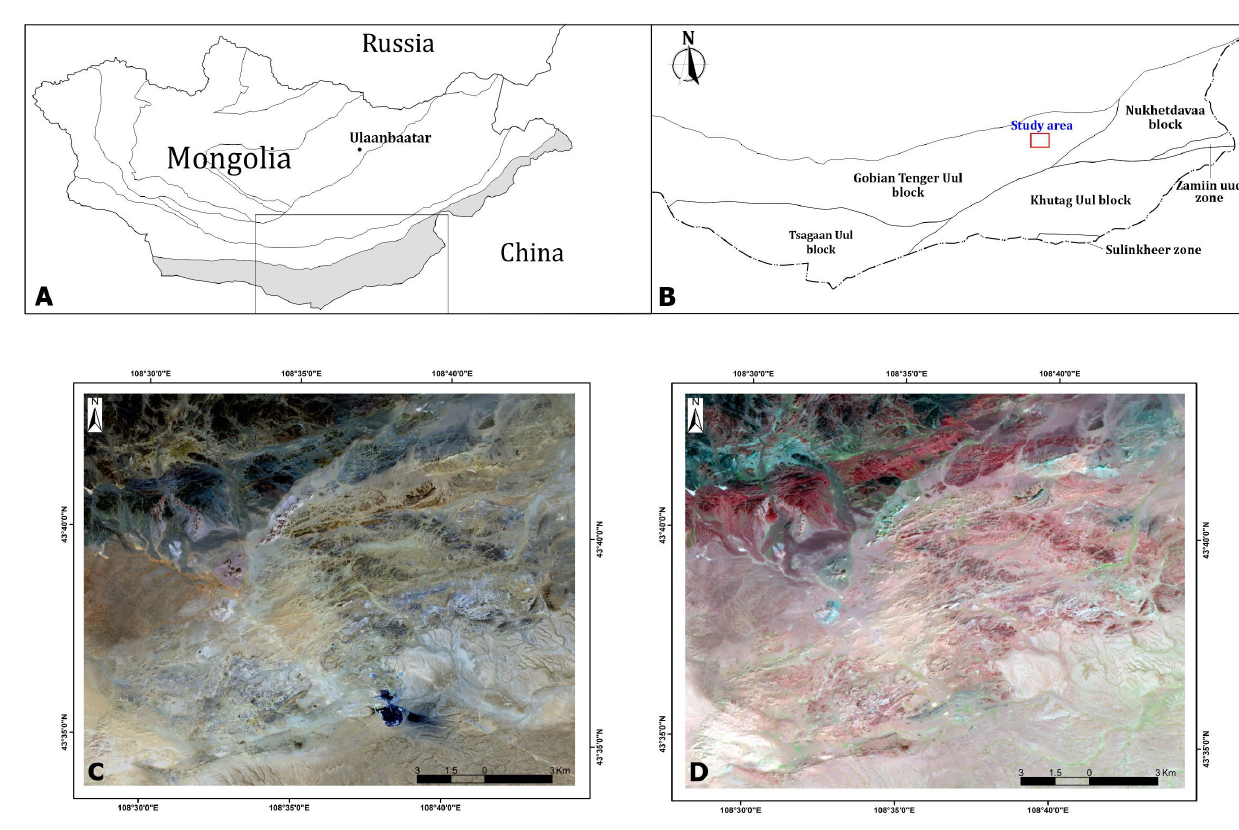
Fig. 1. A. Territory of Mongolia; B. Tectonic division of Mongolia showing the study area (Tomurtogoo, 2017); C. Landsat 8 OLI natural color composite image (RGB:432); D. ASTER false-color composite image (RGB:632) of study area which marked in red